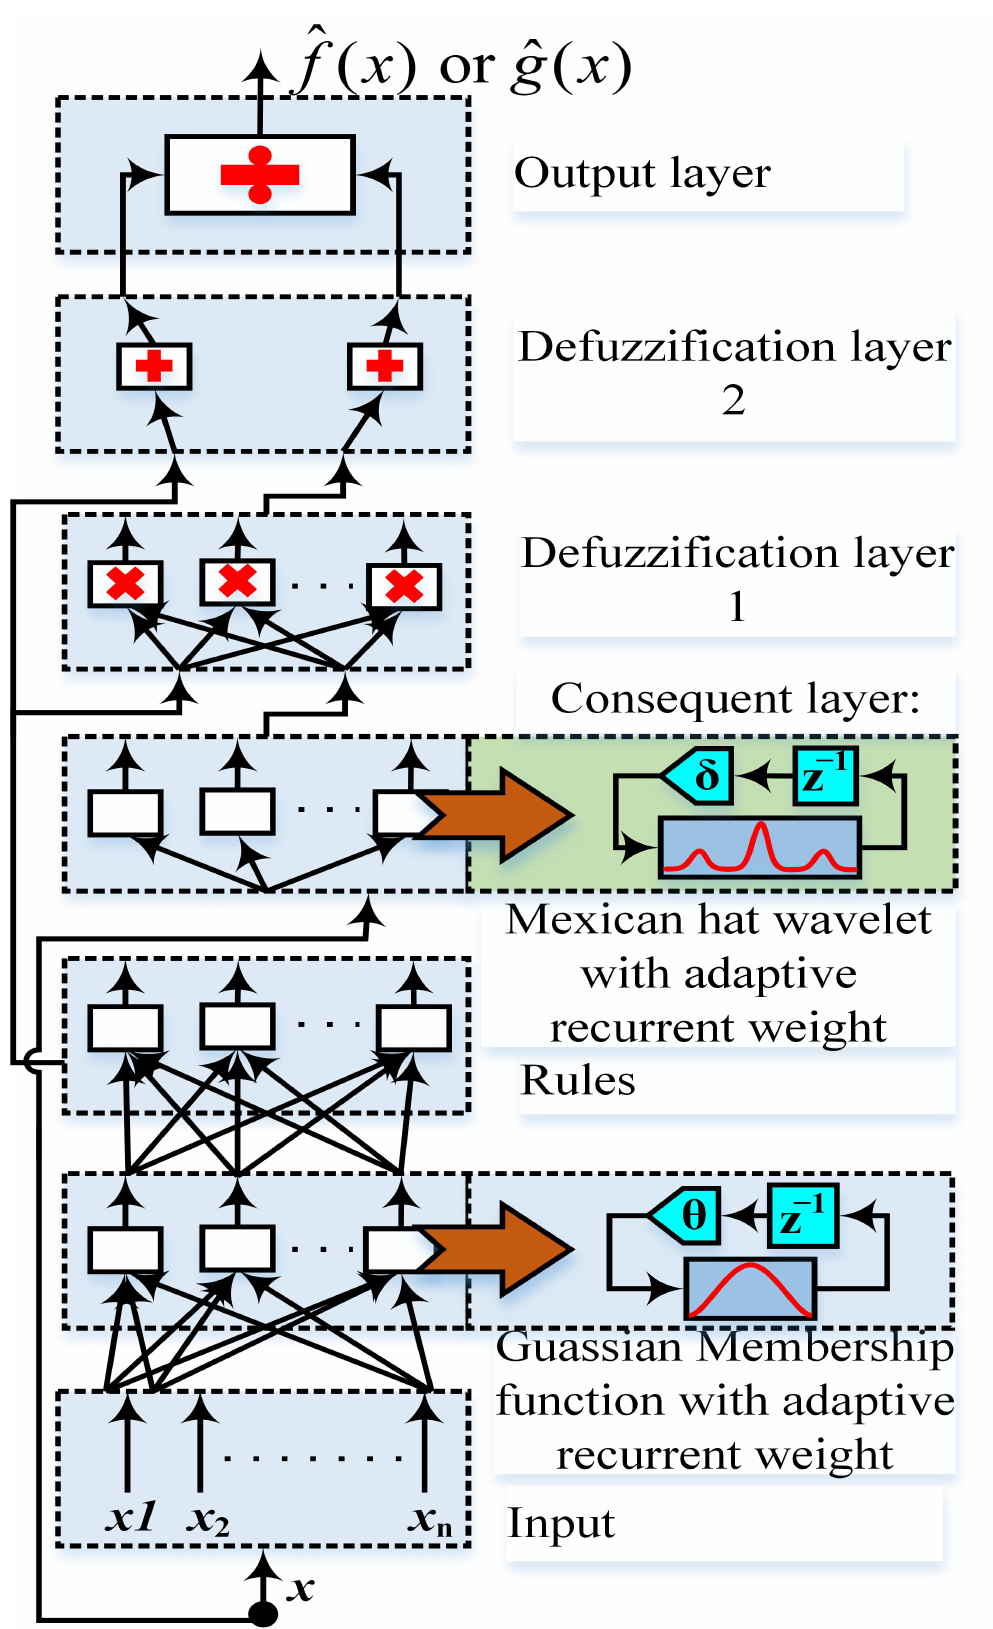
Figure 8. Gaussian membership function with Mexican hat